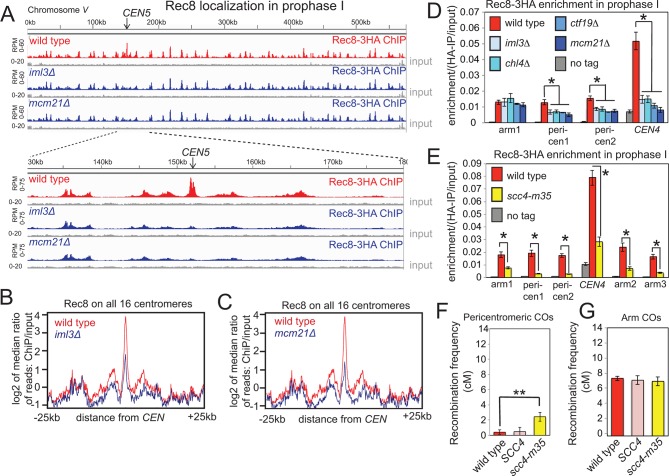
Ctf19-dependent cohesin enrichment prevents pericentromeric COs.(A–D), The Ctf19 complex enriches meiotic cohesin in the pericentromere during prophase I. (A–C) Wild type (AM4015), iml3△ (AM4016) and mcm21△ (AM13833) strains carrying REC8-3HA and ndt80△ were harvested 5h after resuspension in sporulation medium and Rec8 association was analyzed by ChIP-Seq. Rec8 association with chromosome V and a close up of the 50 kb pericentromeric interval is shown (A). The median Rec8 level for all 16 pericentromeric regions is shown over a 25 kb region on each side of the centromere for iml3△ (B) and mcm21△ (C) compared to wild type. (D) Strains as in (A) together with chl4△ (AM4017), ctf19△ (AM20086) and a no tag control (AM11633) carrying ndt80△ were arrested in prophase I by harvesting 5h after being induced to sporulate. The level of Rec8 at the indicated sites was determined by anti-HA ChIP-qPCR. Primer sets used corresponded to sites on the arm of chromosome IV (arm1, 2, 3), within the 20 kb pericentromere (pericen1, 2) or ~150bp from CEN4 (CEN4) and sequences and coordinates are given in Supplementary file 4B. Error bars represent standard error (n=4 biological replicates for iml3△, chl4△, ctf19△ and mcm21△; n=8 for no tag and wild type). *p<0.05, unpaired t test. (E) Chromosomal Rec8 levels are reduced in scc4-m35 cells. Wild type (AM4015), scc4-m35 (AM18211) cells and a no tag control (AM11633) carrying ndt80△ were arrested in prophase I by harvesting 5 hr after being induced to sporulate. The level of Rec8 at the indicated sites was determined by anti-HA ChIP-qPCR. Error bars represent standard error (n=4 biological replicates). *p<0.05, paired t test. (F, G) Map distances (in cM) in the pericentromere (F) or a chromosome arm (G) interval in wild type, a control SCC4 replacement strain, or the scc4-m35 mutant were determined and their significance analysed as described in Figure 1. ChIP-Seq, chromatin immunoprecipitation with sequencing.